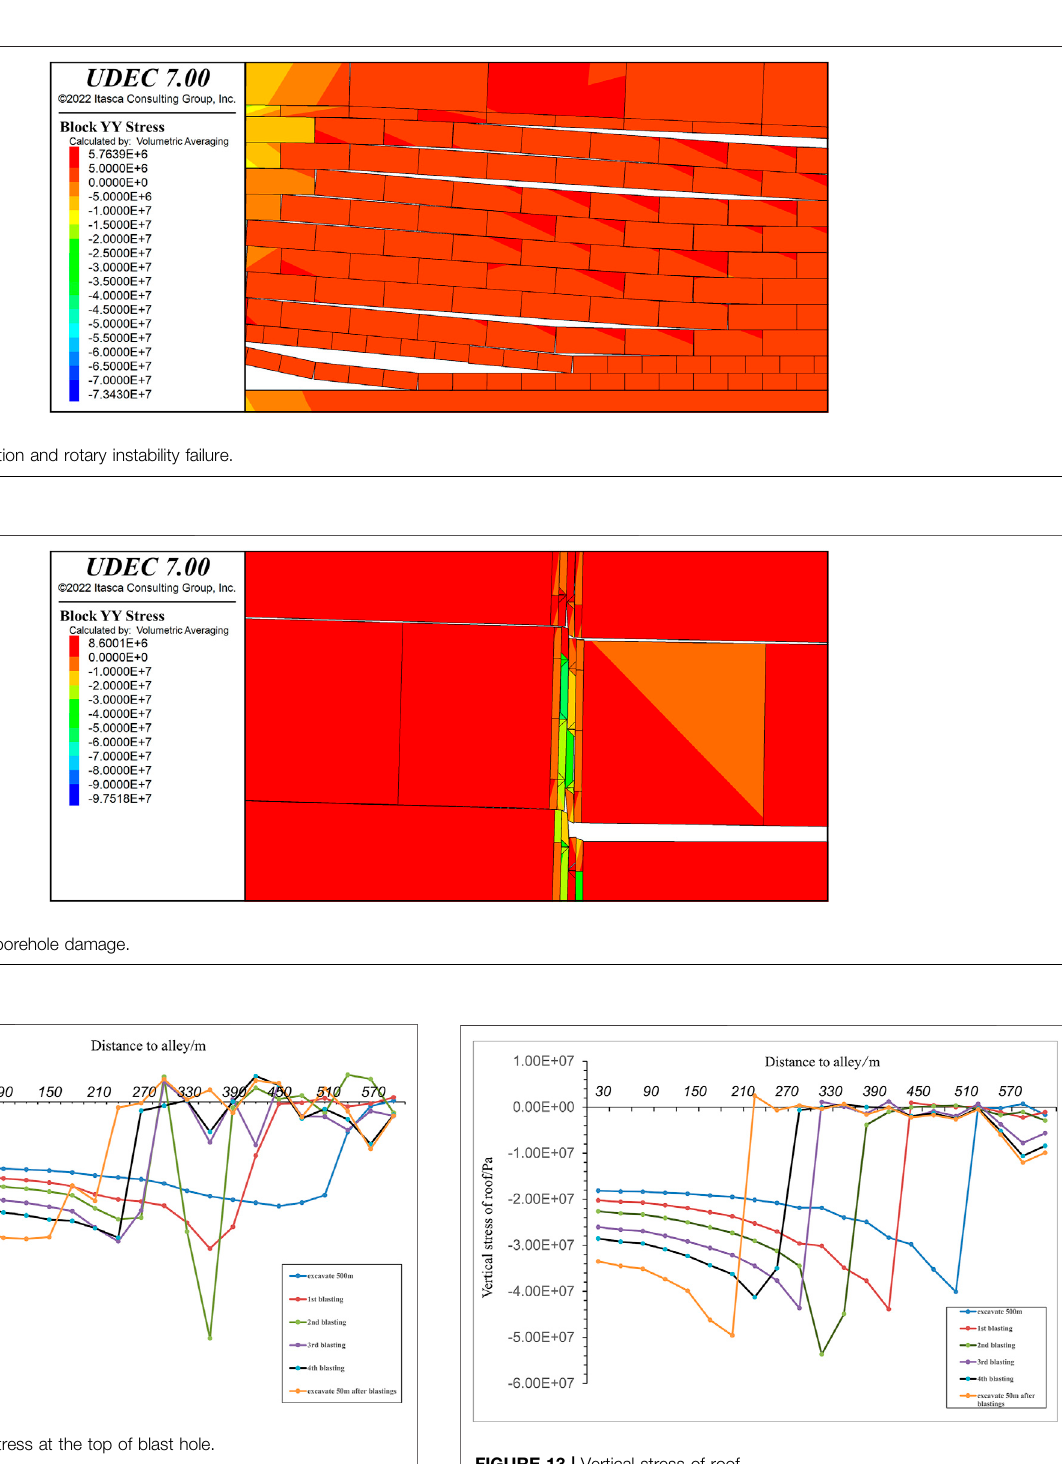
FIGURE 13 | Vertical stress of